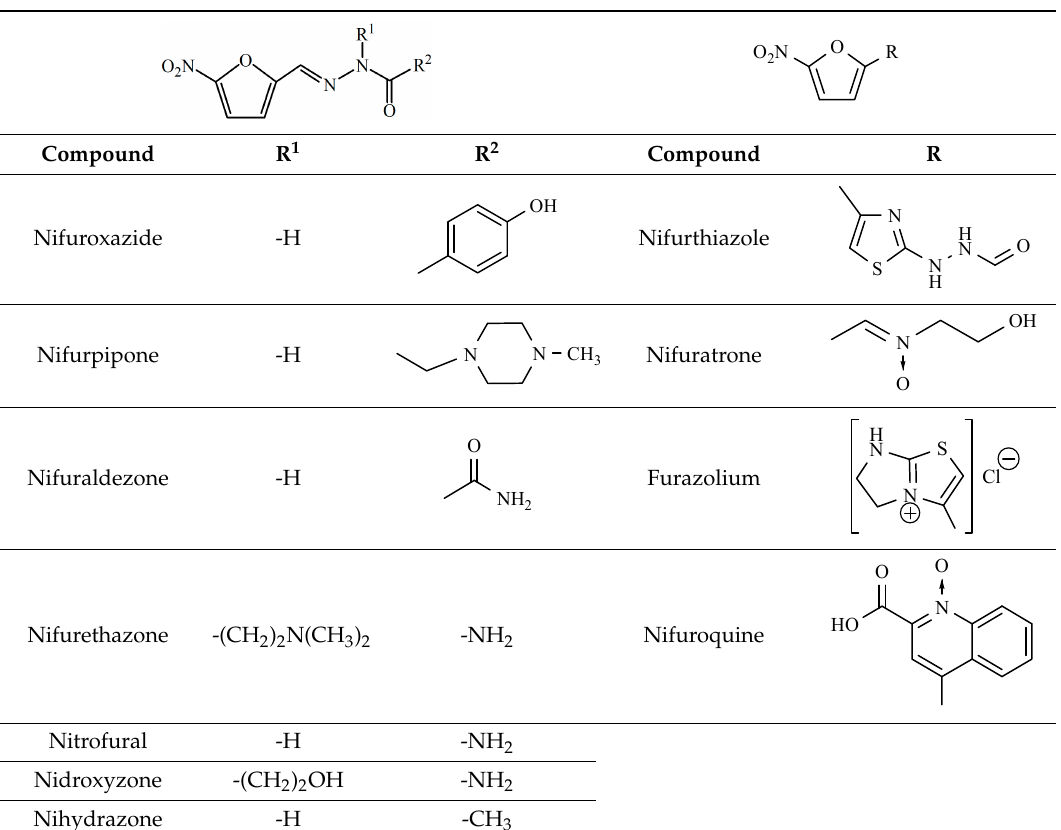
OO Table 3. 5-Nitrofuran analogues with antibacterial activity. Table 3. 5-Nitrofuran analogues with antibacterial activity. Table 3. 5-Nitrofuran analogues with antibacterial activity. Table 3. 5-Nitrofuran analogues with antibacterial activity. Table 3. 5-Nitrofuran analogues with antibacterial activity. Table 3. 5-Nitrofuran analogues with antibacterial activity. Table 3. 5-Nitrofuran analogues with antibacterial activity. Table 3. 5-Nitrofuran analogues with antibacterial activity. Table 3. 5-Nitrofuran analogues with antibacterial activity. Table 3. 5-Nitrofuran analogues with antibacterial activity.